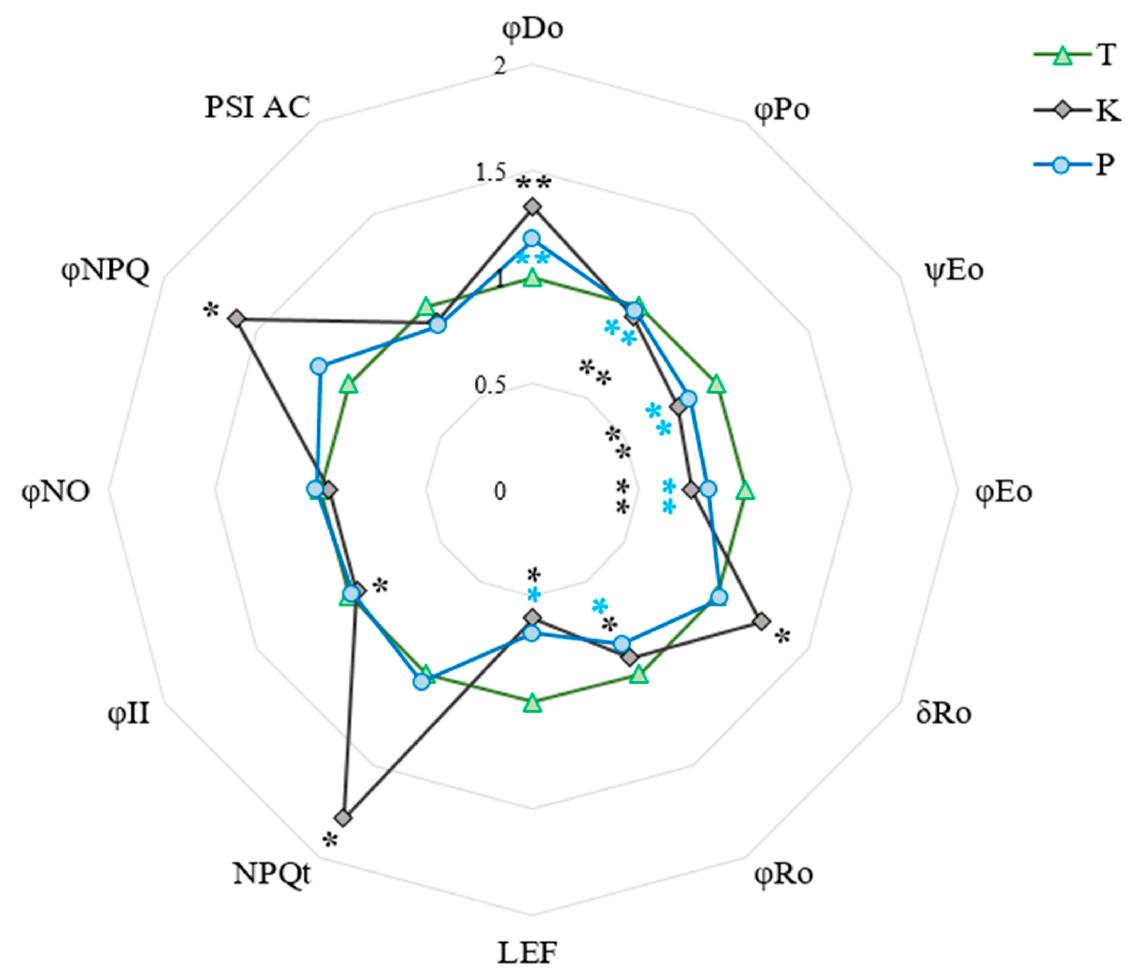
Figure 3. Changes in parameters characterising the state and efficiency of the photosynthetic ap- paratus of birch trees under the influence of environmental factors at investigated sites. The data presented are means (n = 10). Means followed by single asterisks are significantly different from the reference, whereas those with double asterisks differ from both the reference and the other popula- tion, based on the Tukey HSD test ( p ≤ 0.05). Abbreviations: T—reference population from Tychy;